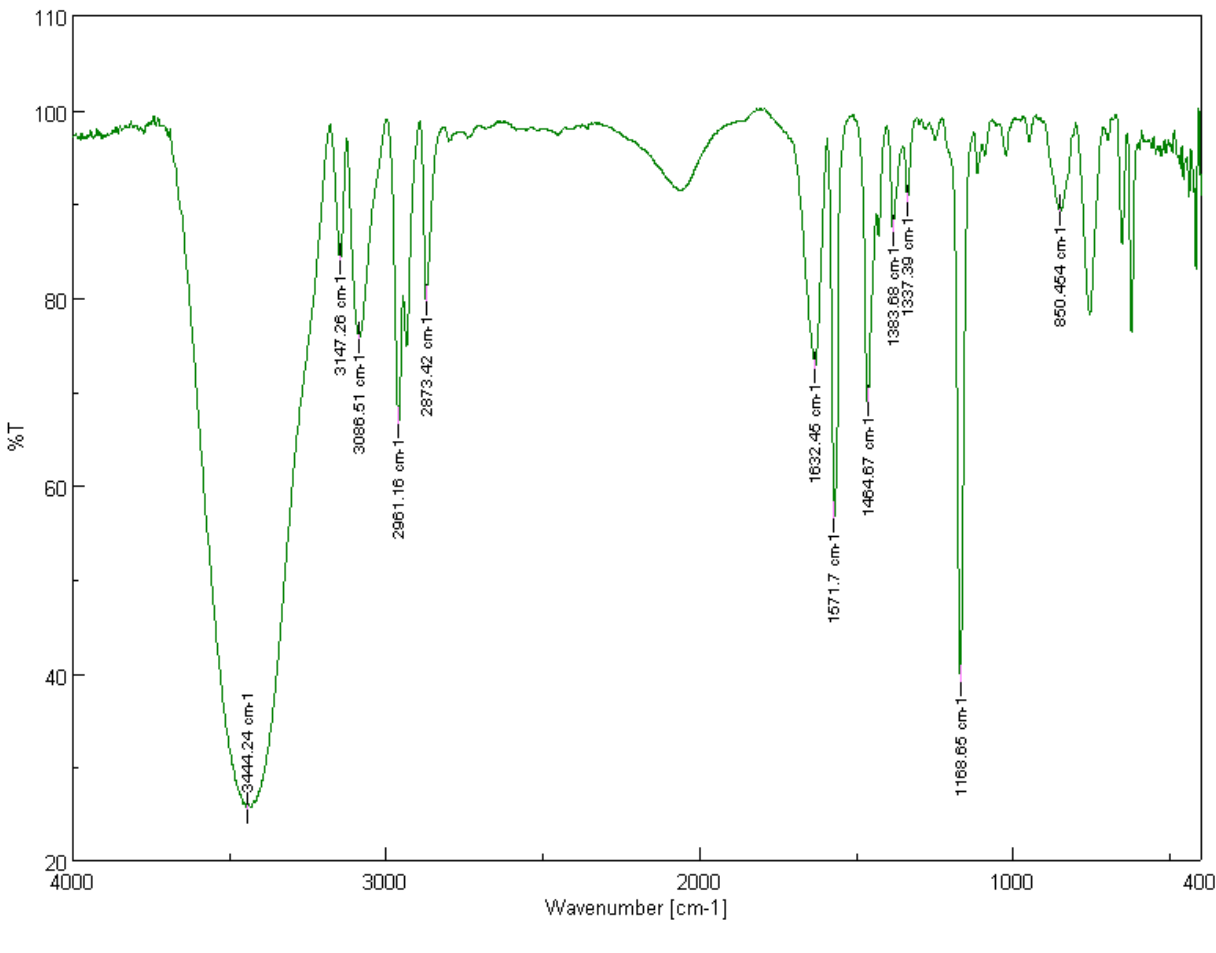
Figure 12. Solid-state FT-IR spectrum of the recycled [BMIM][Br]. Sample pellet with KBr, number of scans: 32, resolution: 4.0 cm − 1 .